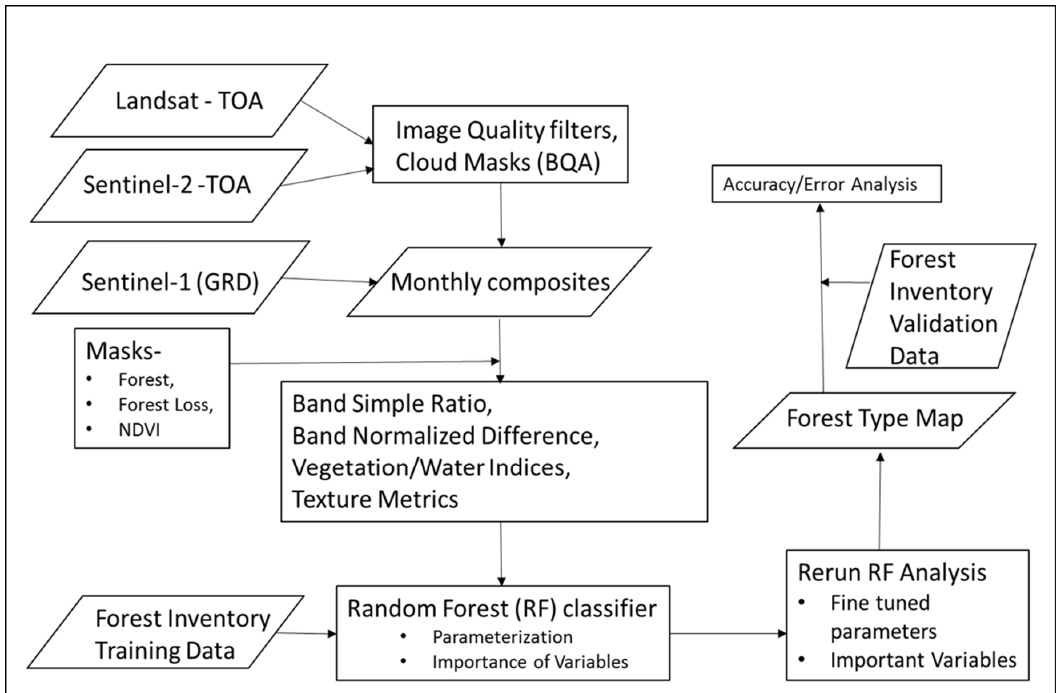
Figure 2. Overview of image processing and classification steps to map forest types from satellite imagery for the Bago Region of Myanmar. TOA: Top Of Atmosphere; GRD: Ground Range Detected; NDVI: Normalized Difference Vegetation Index.